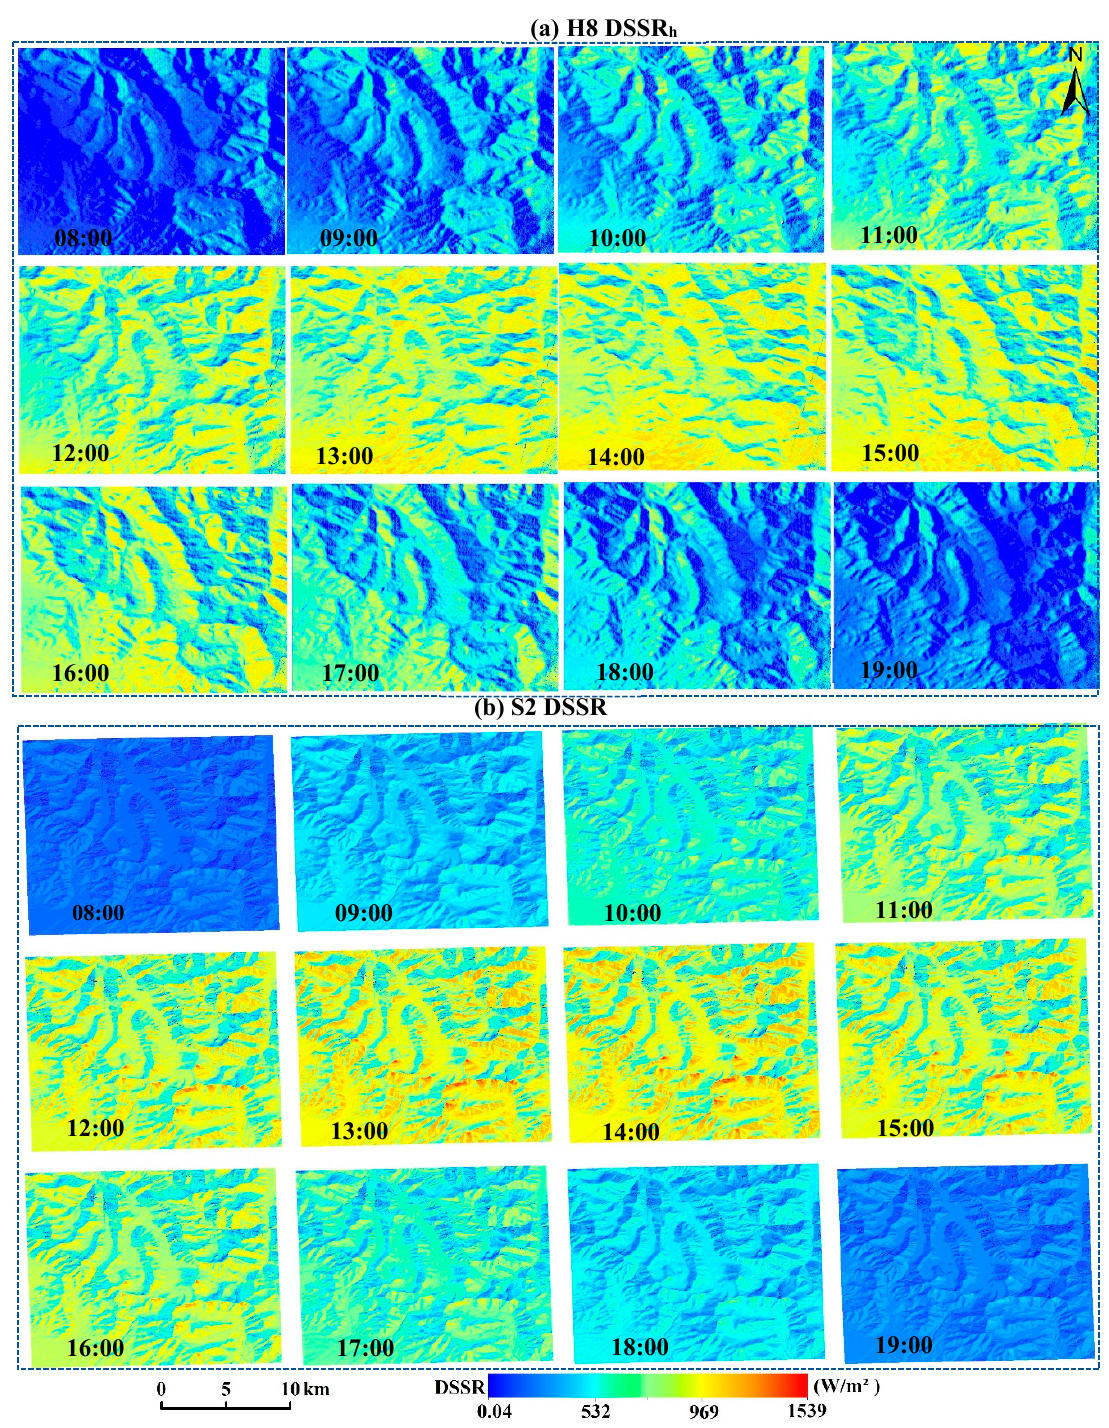
Figure 10. Spatial distribution of the H8 spatial downscaled DSSR and the S2 DSSR estimated by the sinusoidal model for 17 August 2018: ( a ) H8 DSSR h and ( b ) S2